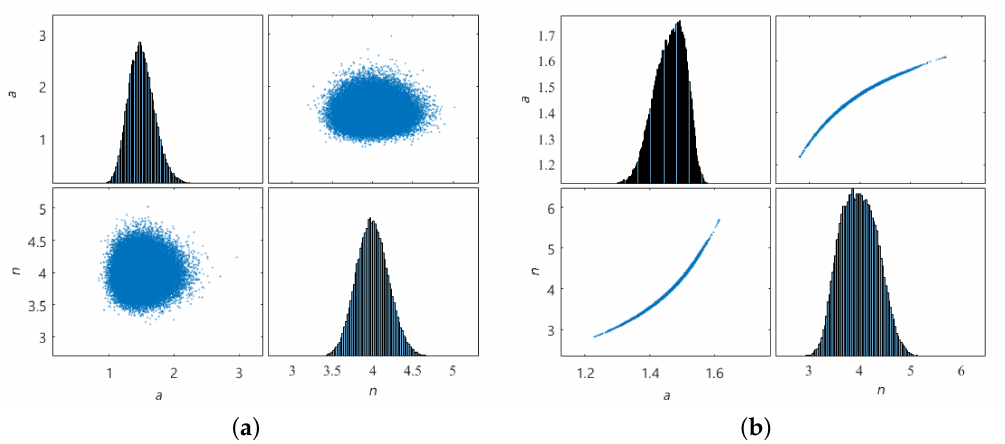
Figure 10. Results of using 1000 sets of water content monitoring data to update: ( a ) prior distribution; ( b ) posterior distribution.